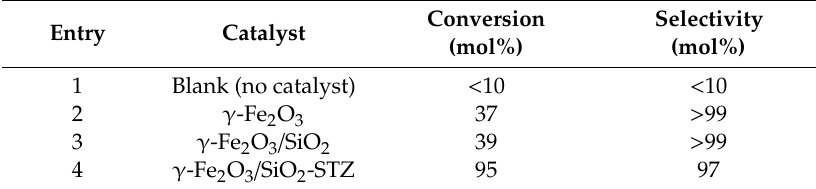
Figure 3. Magnetic curves of γ -Fe 2 O 3 /SiO 2 -STZ. Inset: Left, reaction mixture containing γ -Fe 2 O 3 /SiO 2 - STZ. Right, γ -Fe 2 O 3 /SiO 2 -STZ collected by using an external magnet after the reaction.